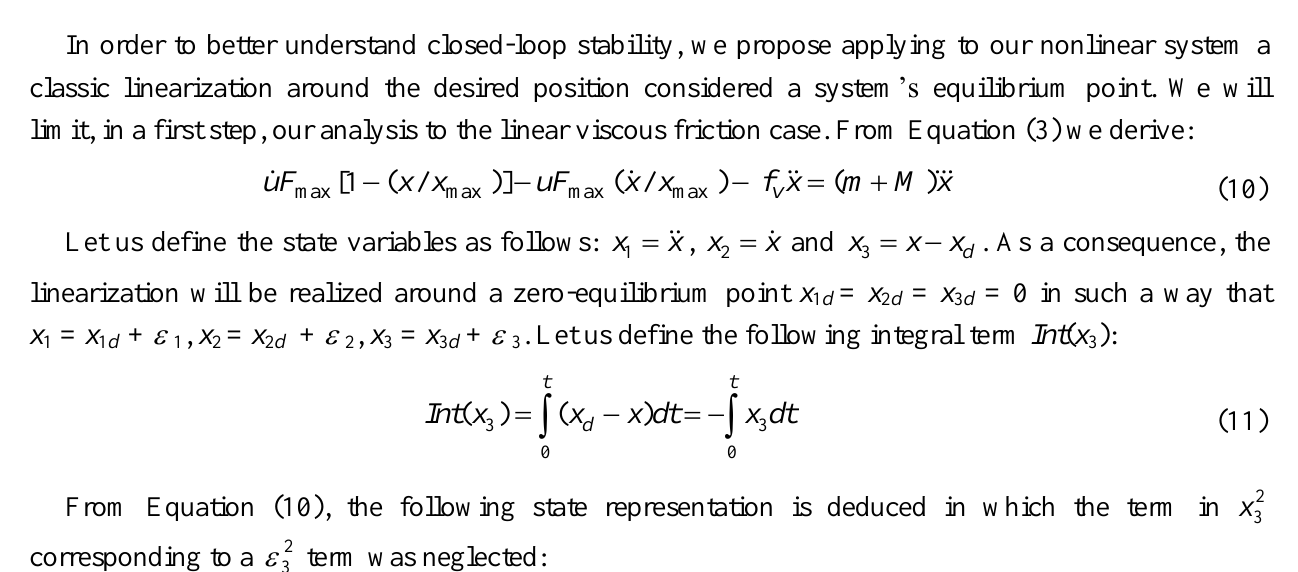
variation in the case of the I